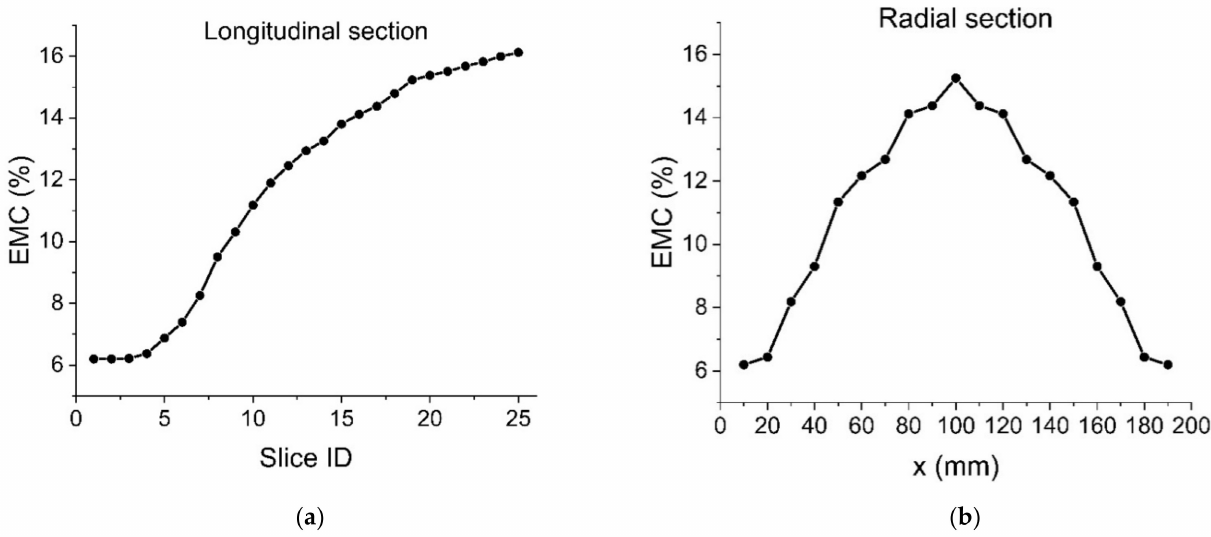
Figure 12. Final EMC values after 160 days. ( a ) EMC in longitudinal direction, as a function of the slices along the main axis of the beam (S1–10 mm; S2–30 mm; S3–50 mm . . . S25–490 mm). ( b ) EMC in radial direction, as a function of the radial depth within a single